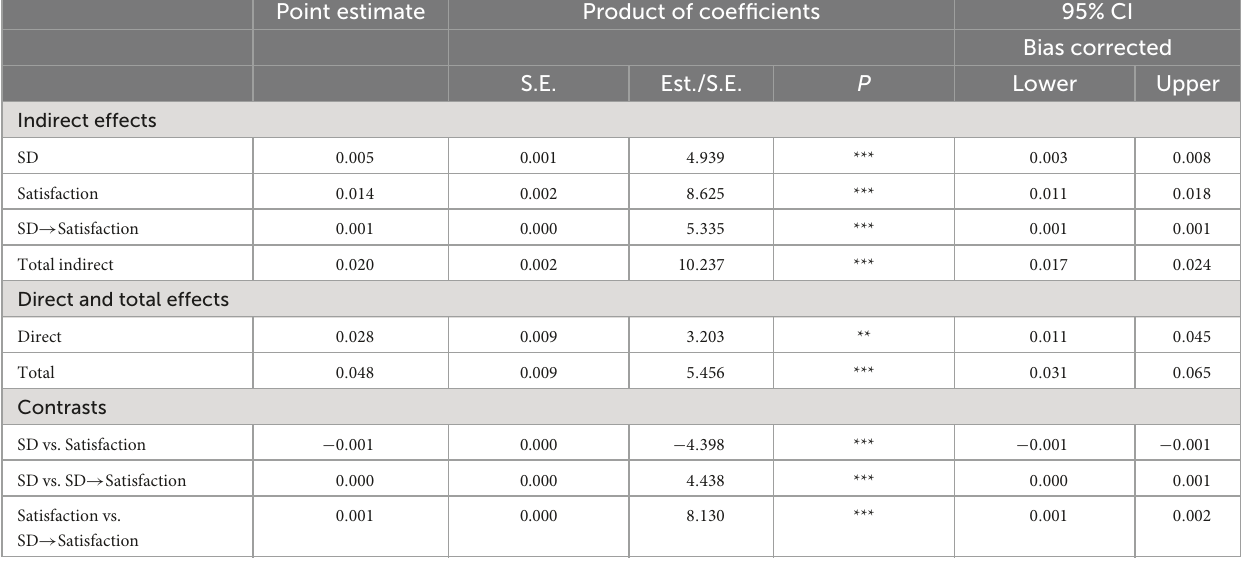
TABLE 8 Total, direct, and indirect effects of ACEs on ADL, sleep duration and satisfaction as